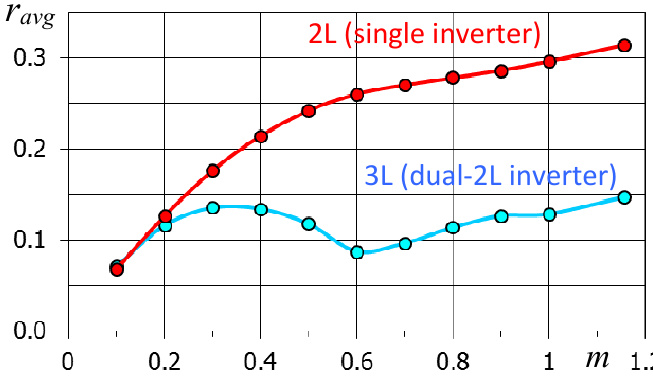
Figure 5. Average normalized current ripple vs. modulation index for single-2L and dual-2L (3L)